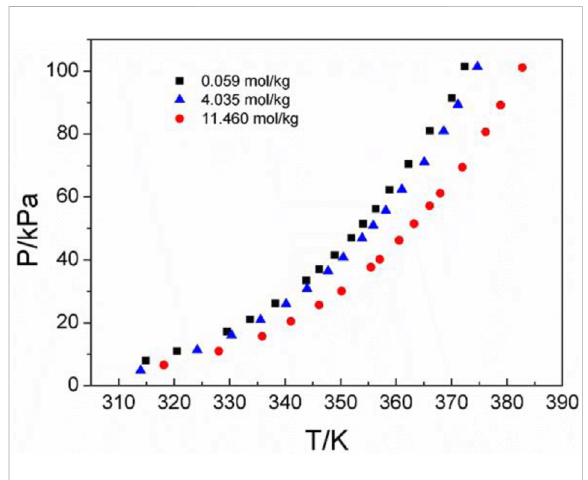
FIGURE 3 Vapor – liquid equilibrium in the three different saturated amino acid aqueous solutions. Full symbols represent experimental data (this work). Black square represents L -glutamic acid, blue triangle represents L -serine, and red circle represents DL